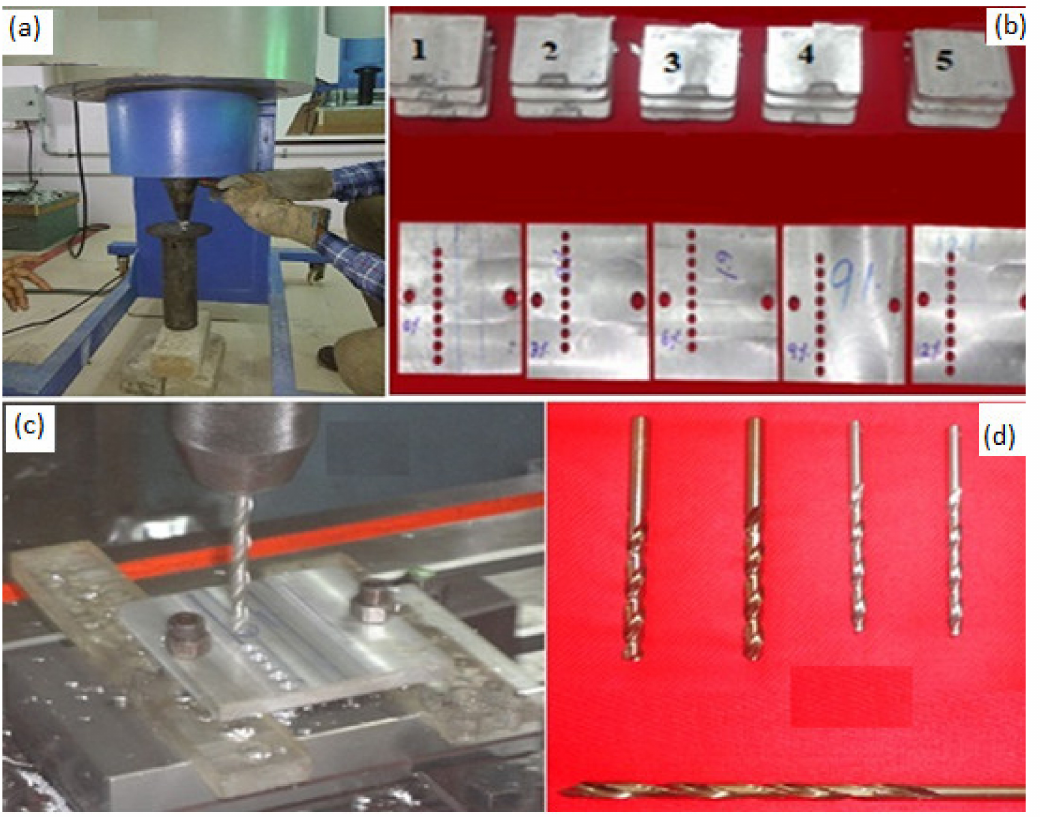
Figure 1. ( a ) Synthesis of in situ AA7075/TiB 2 composites. ( b ) Samples before drilling and after drilling (0, 3, 6, 9 and 12 wt.%). ( c ) A sample at drilling and ( d ) the drill bits